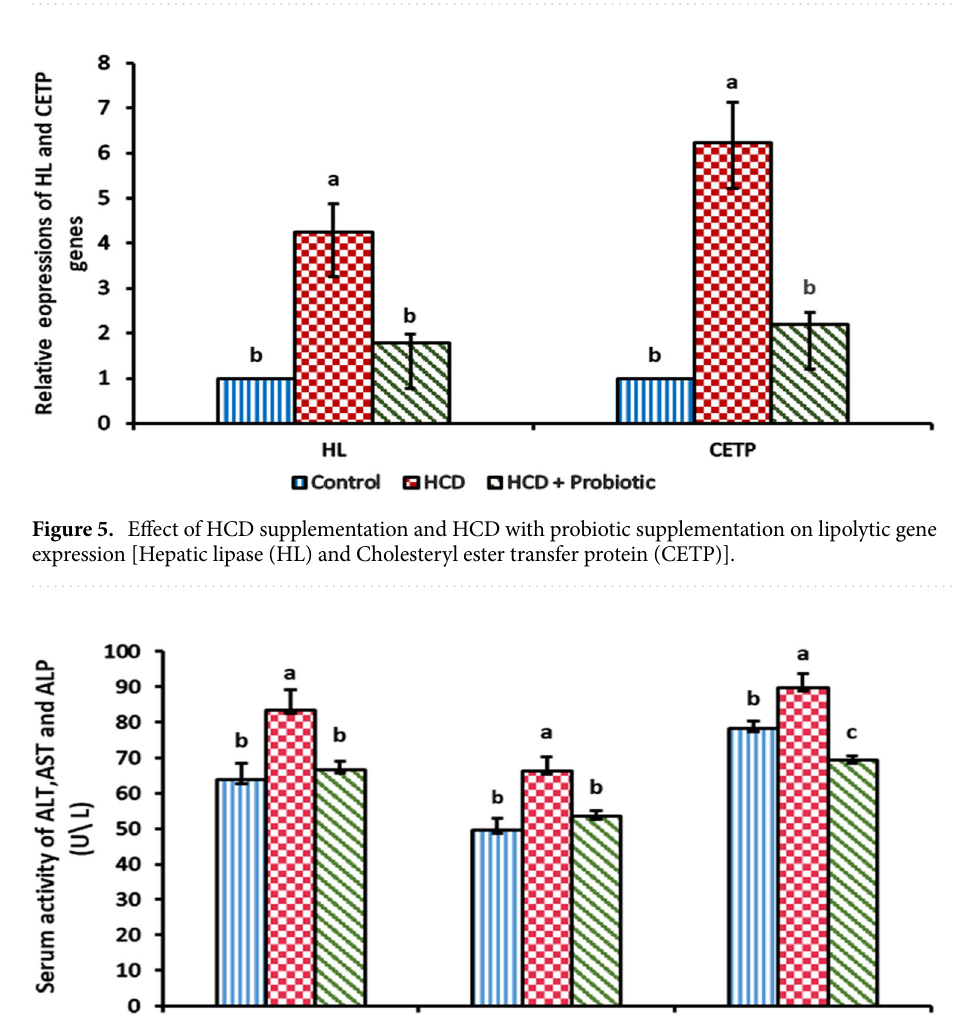
Figure 4. Effect of HCD supplementation and HCD with probiotic supplementation on lipolytic gene expression [Lipoprotein lipase (LPL) and Low-density lipoprotein receptor (LDLr)].